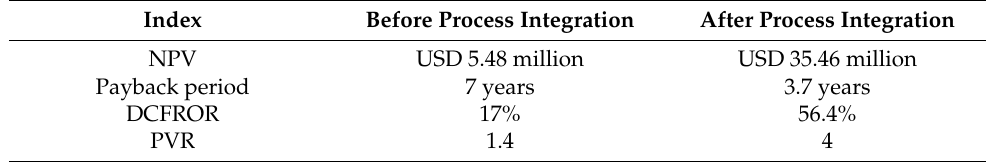
Table 5. Process profitability